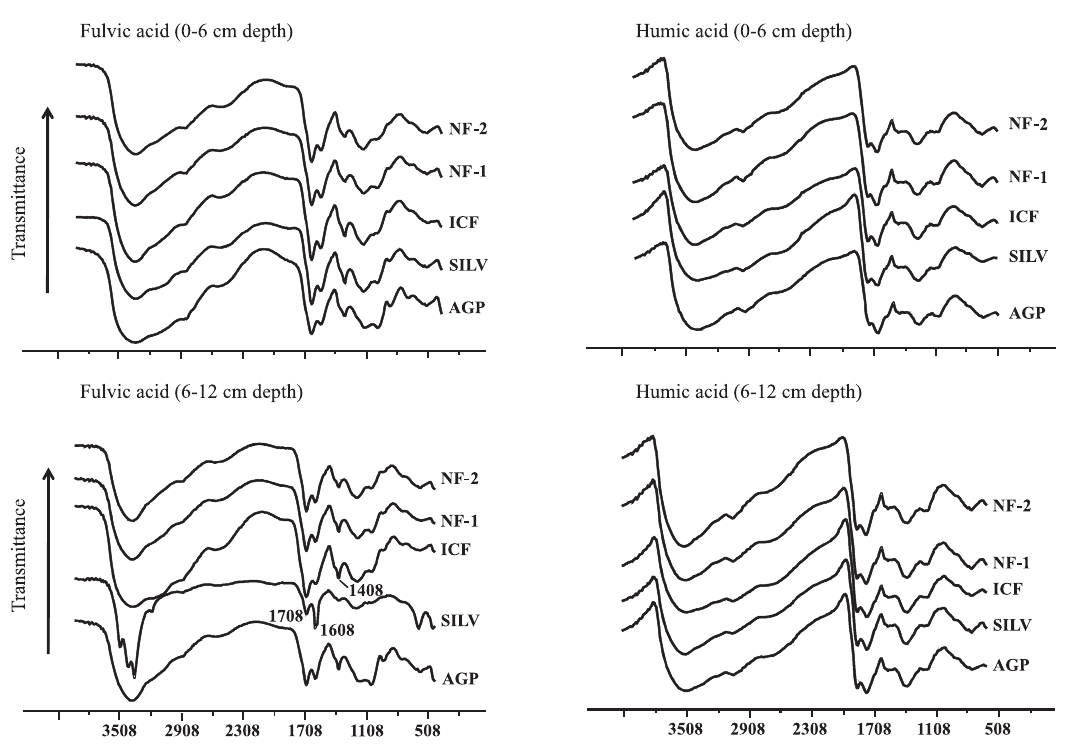
Figure 4. Infrared spectra of fulvic and humic acids extracted from the 0–6 and 6–12 cm layers of a Chromic Luvisol under agroforestry, intensive cultivation, and native forest. AGP: agrosilvopasture; SILV: silvopasture; ICF: intensive cultivation under fallow; NF-1: native forest compared to AGP and SILV treatments; NF-2: native forest compared to the ICF Table 5. Assignment of Fourier transform infrared (FTIR) spectral peaks indicating the main functional groups of fulvic and humic acids extracted from the 0–6 and 6–12 cm layers of a Chromic Luvisol under agroforestry, intensive cultivation, and native forest